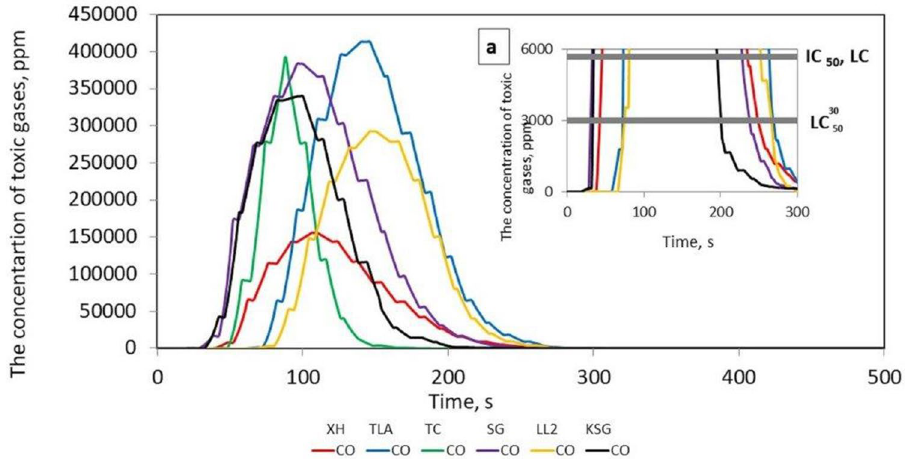
Figure 4. CO concentration as a function of time during thermal decomposition and combustion of the tested belt samples with permissible values (Table 2).